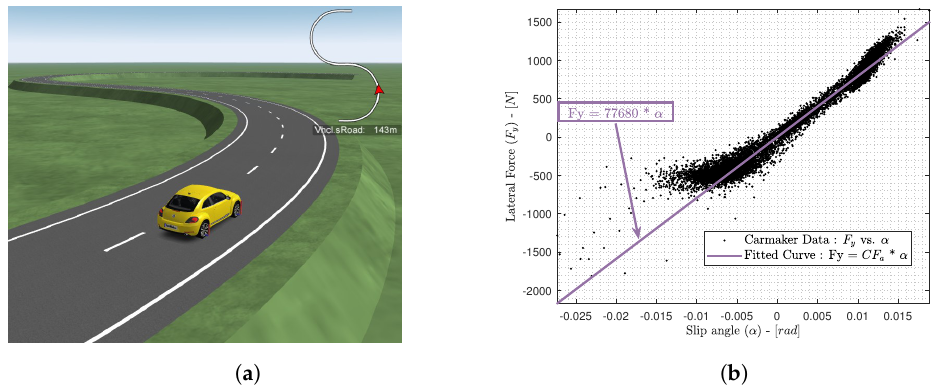
Figure 6. ( a ) The IPG/CarMaker demo vehicle used in this work and ( b ) the evaluation of its tyre cornering stiffness.